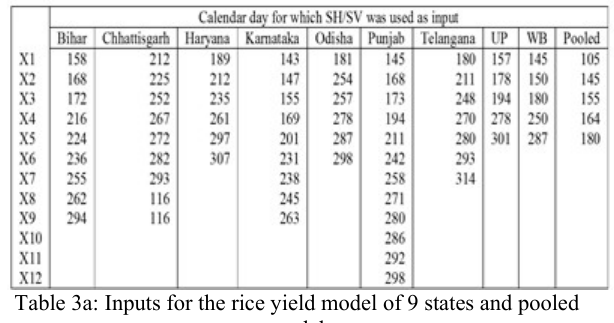
Table 3a: Inputs for the rice yield model of 9 states and pooled